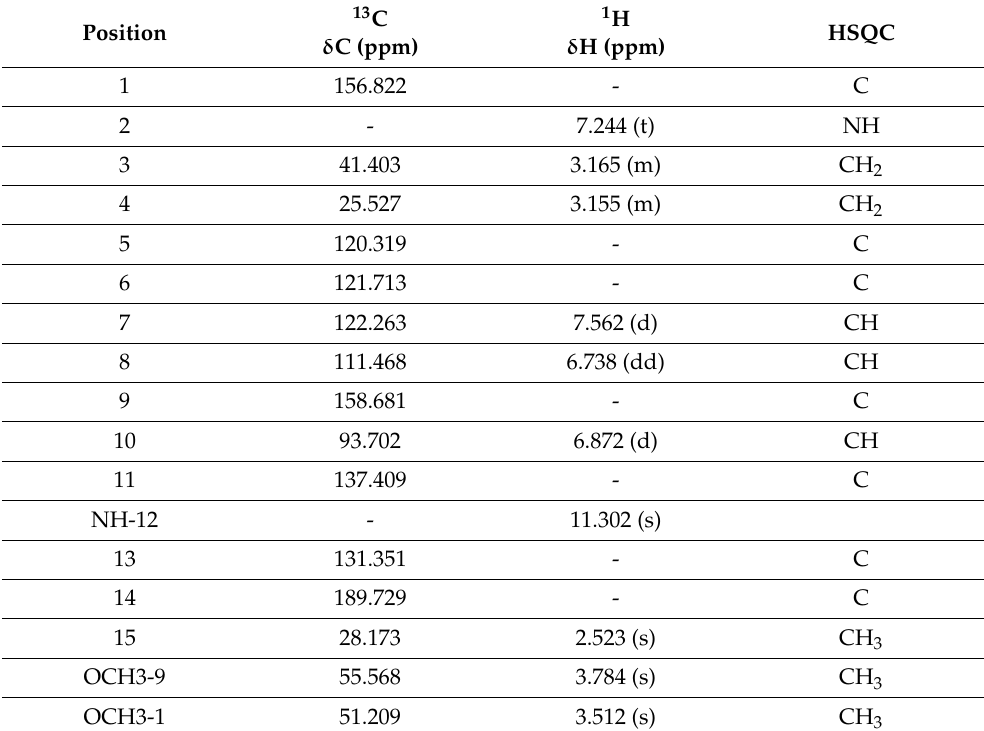
Figure 6. Structure of PH ‐ HM ‐ 10 (Pegaharmine E). Table 3. NMR ( 1 H and 13 C) chemical shifts value of PH ‐ HM ‐ 10.